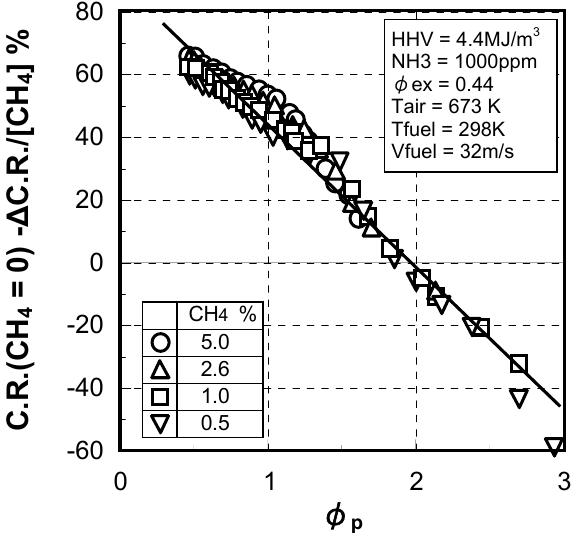
Figure 22. Prediction of relationship between CH of conversion rates of NH in cases where fuels contain no CH